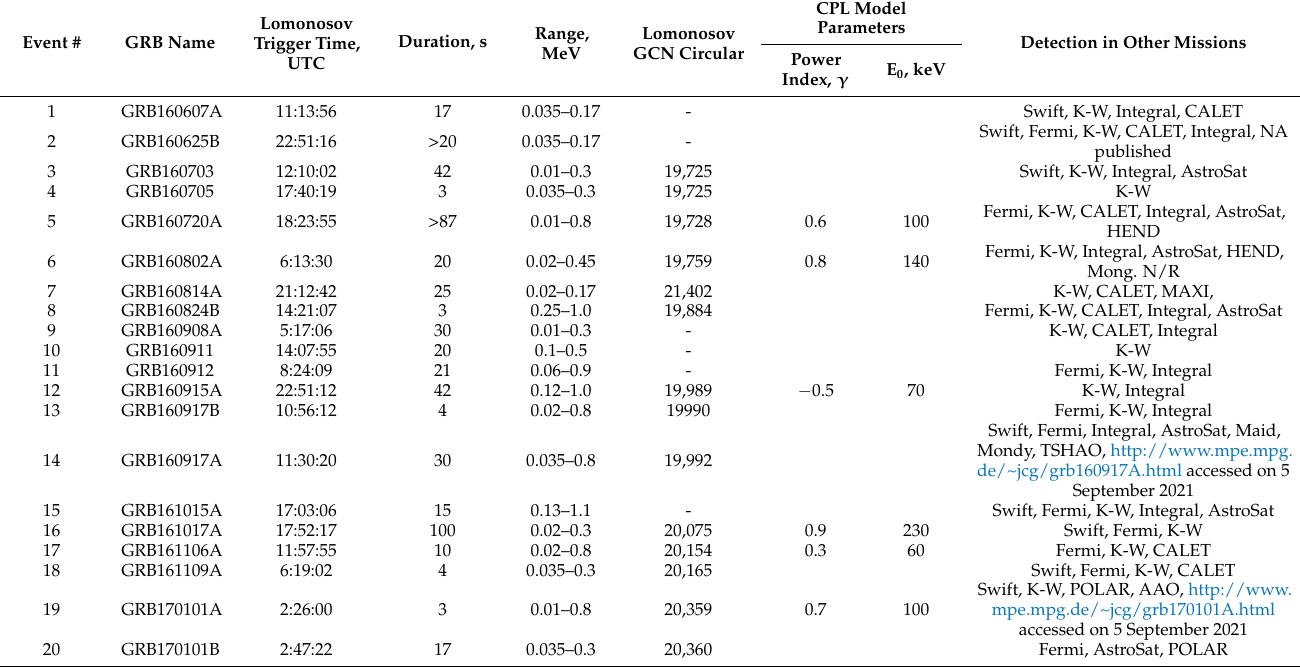
Table 3. List of GRBs detected using BDRG/ Lomonosov .